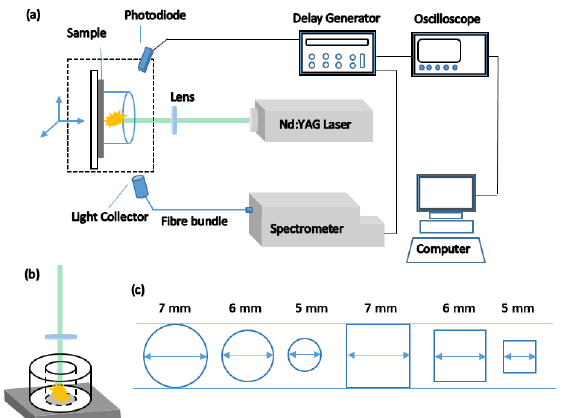
Figure 1. ( a ) The schematic diagram of the cavity confinement of the laser-induced plasma, ( b ) the image of the circular cavity confinement, ( c ) the diagram shows the circular cavities with three different sizes (5, 6 and 7 mm) and square cavities of three different lengths of sides (5, 6, 7 mm) used for the confinement.